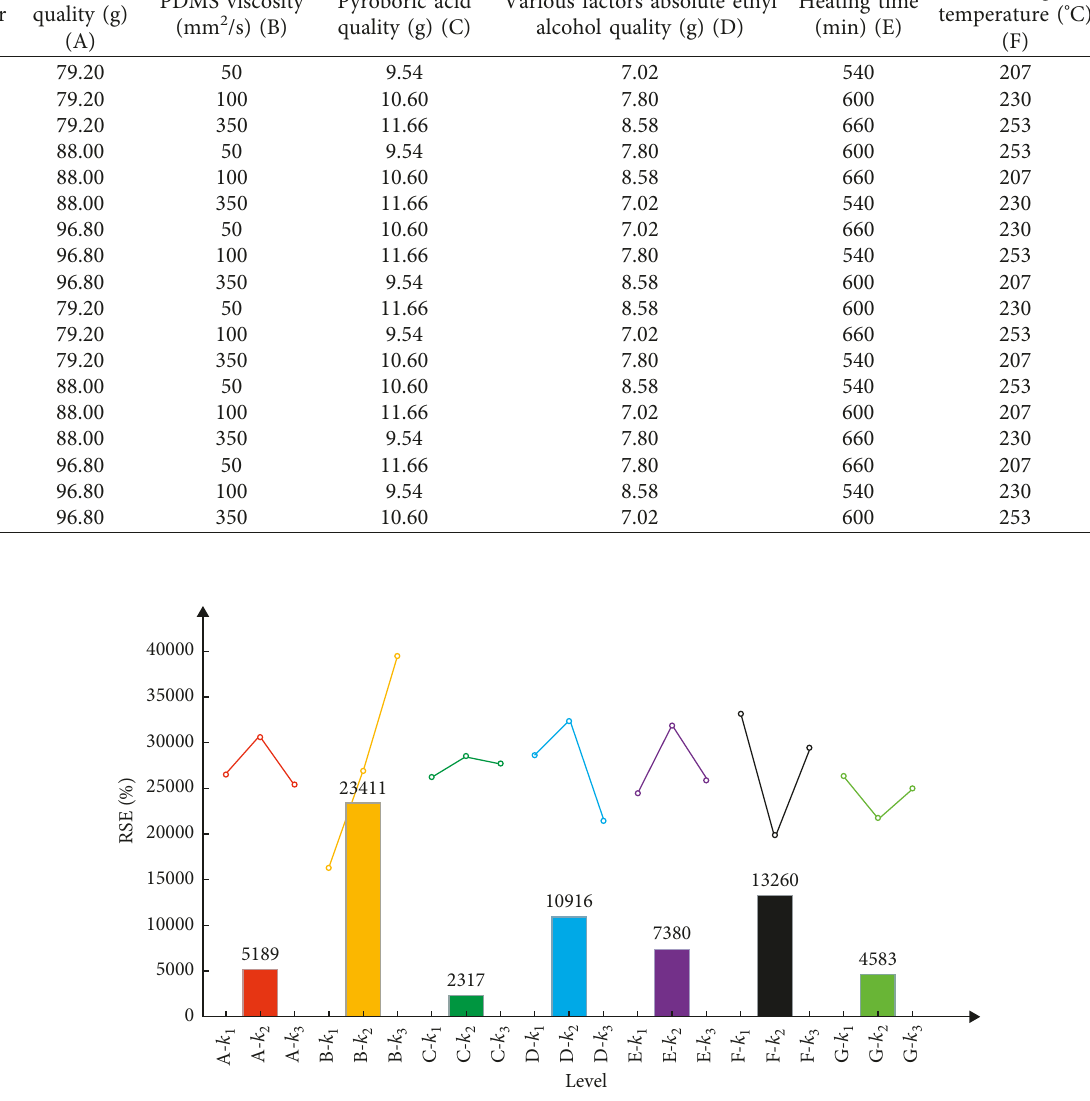
Figure 3: The average RSE of each factor under different